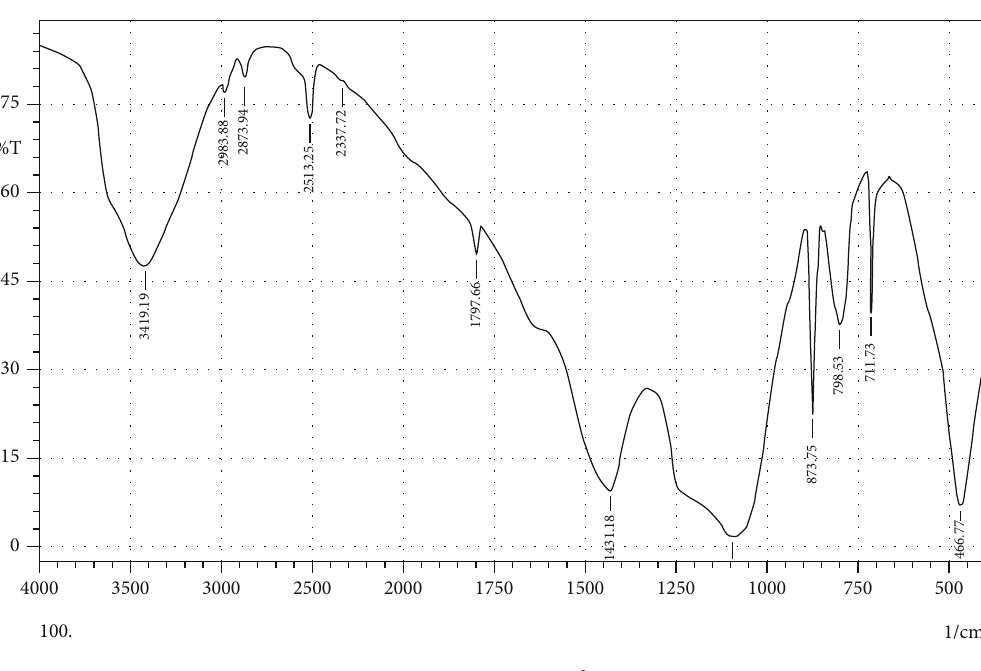
Figure 4: IR spectrum of